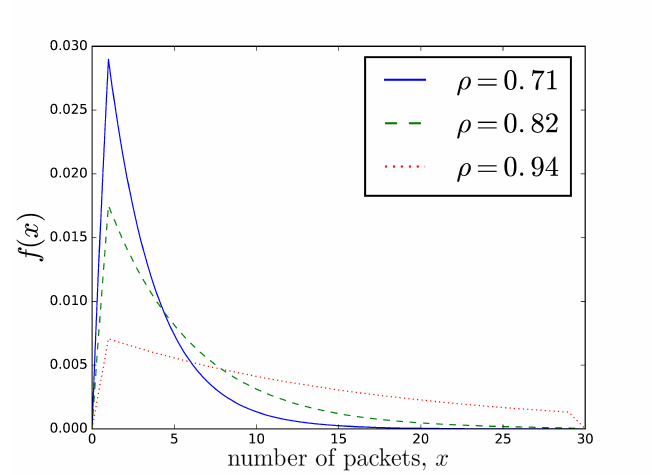
Figure 2. Steady-state pdf f ( x ) of the diffusion process as an approximation of the queue distribution: illustration of the solution in Equation